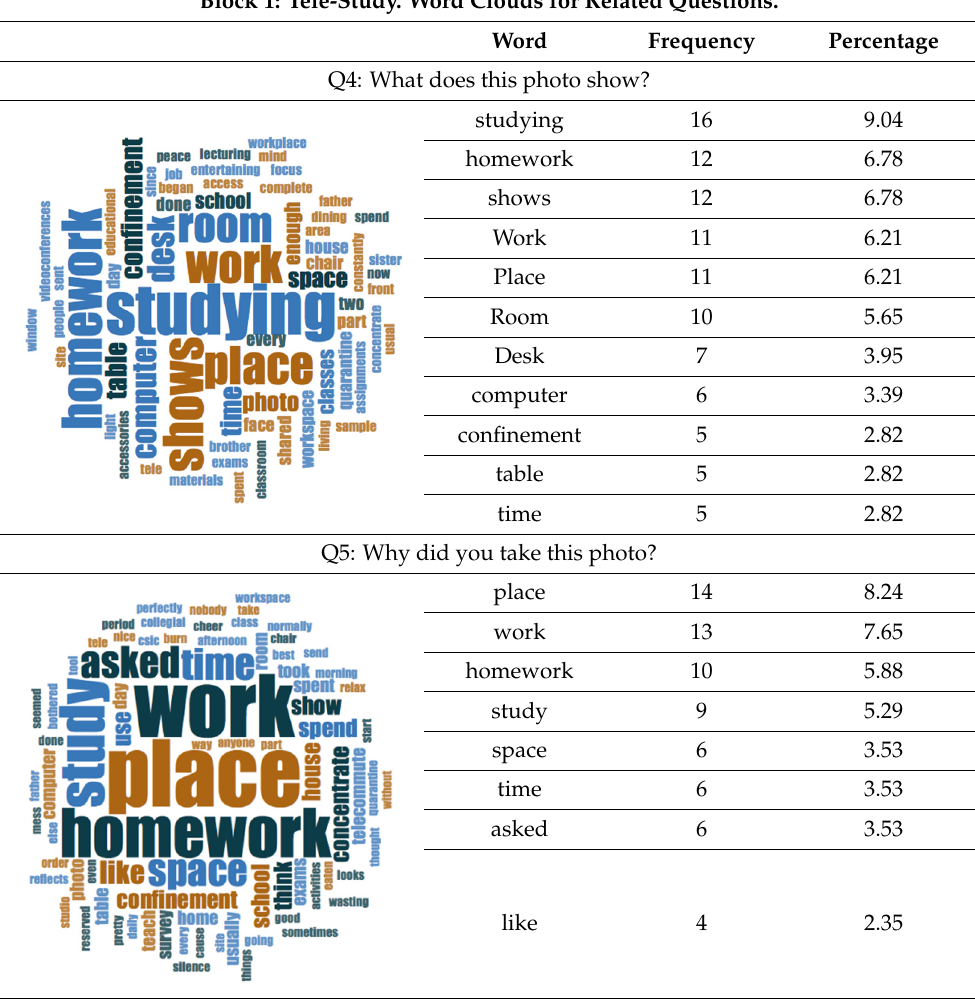
Table 4. Word clouds referred to picture-related questions on tele-study spaces at home. Block 1: Tele-Study. Word Clouds for Related Questions.